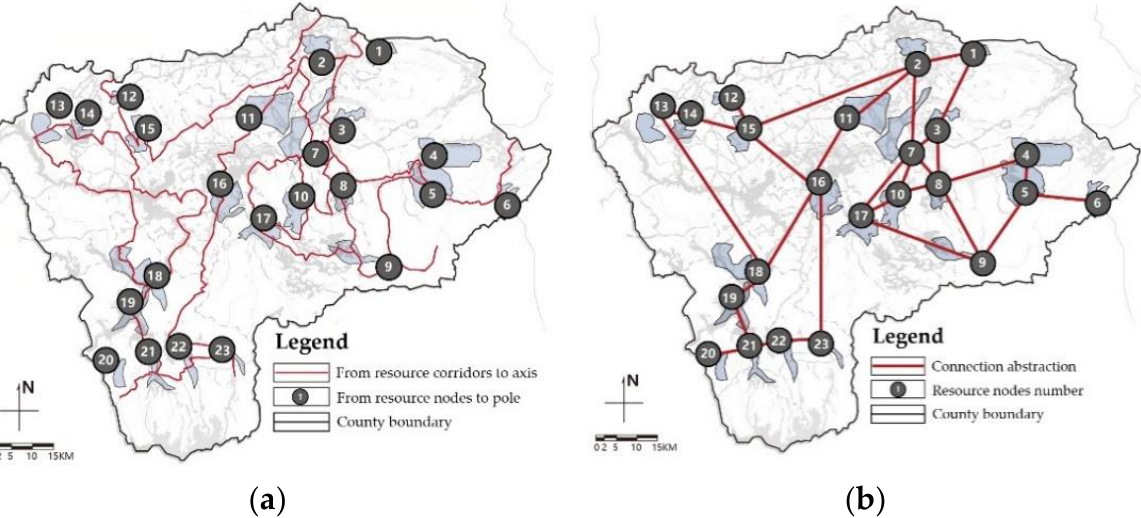
Figure 7. Abstraction and connection of resources: ( a ) geometric abstraction of resource nodes and resource corridors, and ( b ) abstract resource connection.